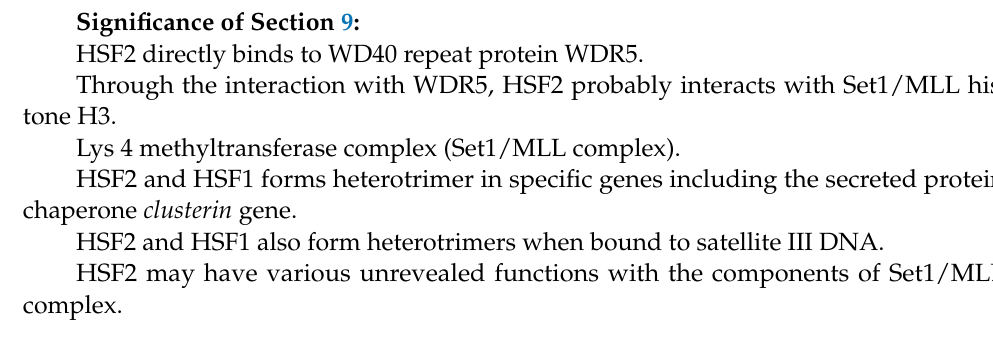
Figure 3. Interaction of HSF2 and Set1/MLL complex HSF2. Set1/MLL histone H3K4 methyltrans- ferase and HSF2 probably form a large complex via WDR5 [2].